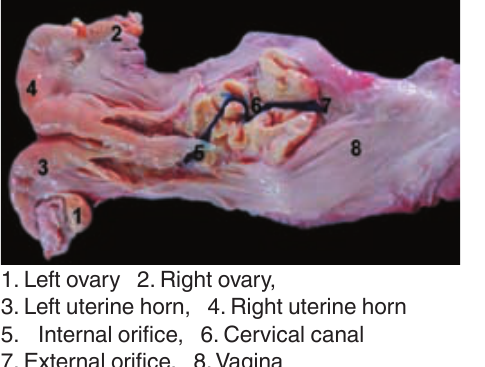
Fig. 2. Bent cervical lumen in kinked cervix